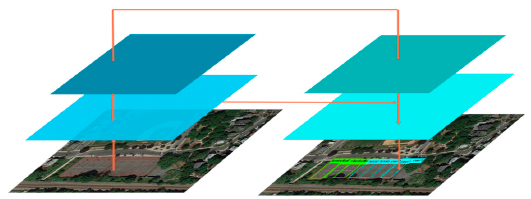
Figure 1. Multi-scale prediction in the YOLOv3-tiny network. There are two scales prediction in the YOLOv3-tiny network. The sizes of the tensors are 13 × 13 and 26 × 26, respectively.